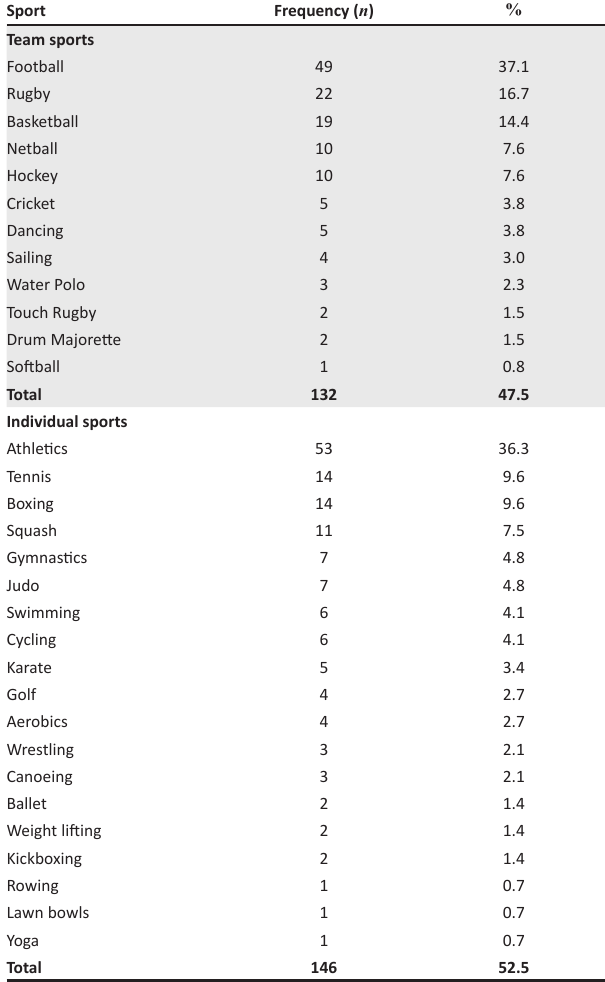
TABLE 1: Frequencies of team and individual sports represented in the